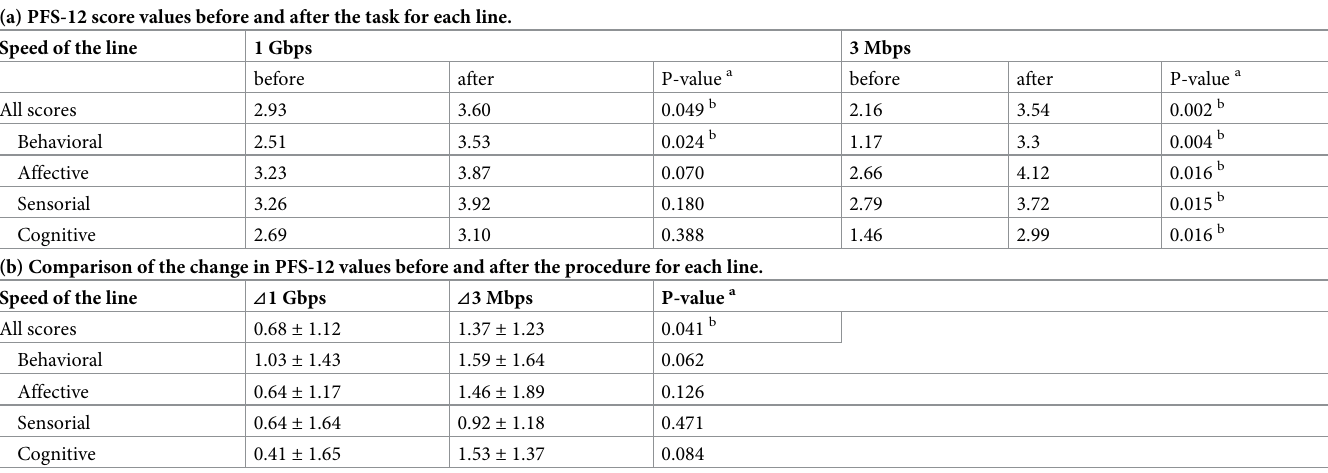
Table 2. Comparison of the Piper Fatigue Scale-12 (PFS-12) between line